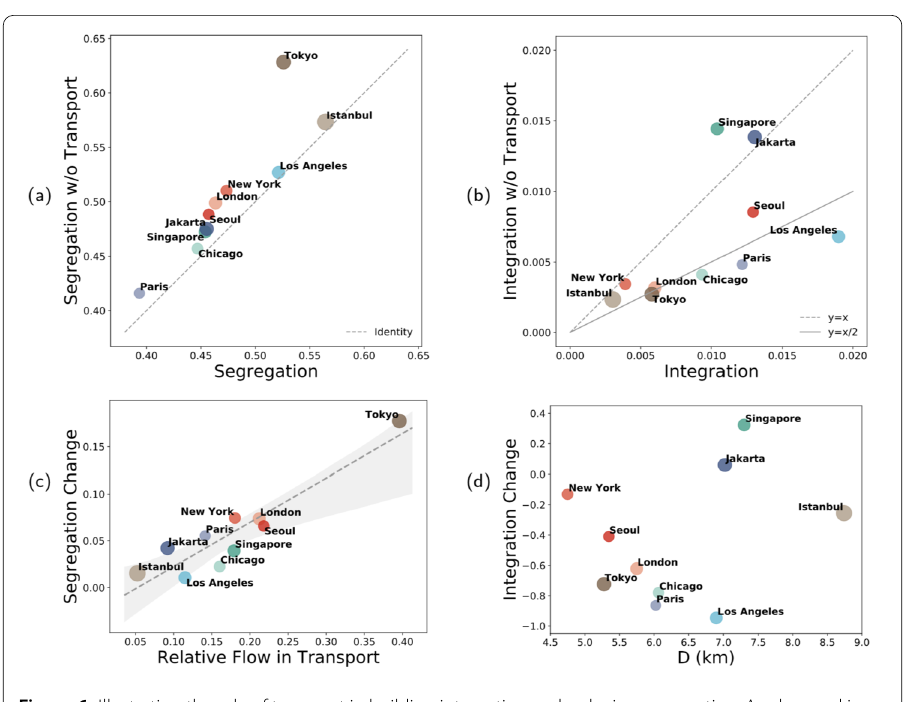
Figure 6 Illustrating the role of transport in building integration and reducing segregation. As observed in Fig. 5(b), the removal of the transport layer modifies significantly a city segregation and integration. ( a ) Segregation always increases after removing the transport layer. ( b ) Integration drops after removing the transport layer for some cities (that may reach values as smaller as the half of the initial value) but remains similar or even raises for other. ( c ) The raise in segregation grows linearly with the fraction of total flow represented by in the transport layer. ( d ) The relative change in integration ( GCE removed – GCE full )/ GCE full is not simply linked to the length of the connections cut: while for seven cities it seems to follow a trend similar to that pointed out in Fig. 5(c), for three cities where the average connection length of the transport layer is